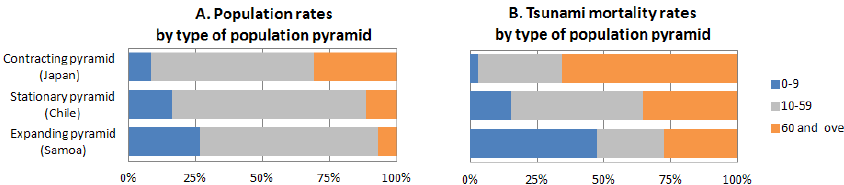
Figure 7. Comparison between (a) population rates and (b) tsunami mortality rates by age and type of population pyramid (tsunami events of Japan 2011, Chile 2010 and Samoa